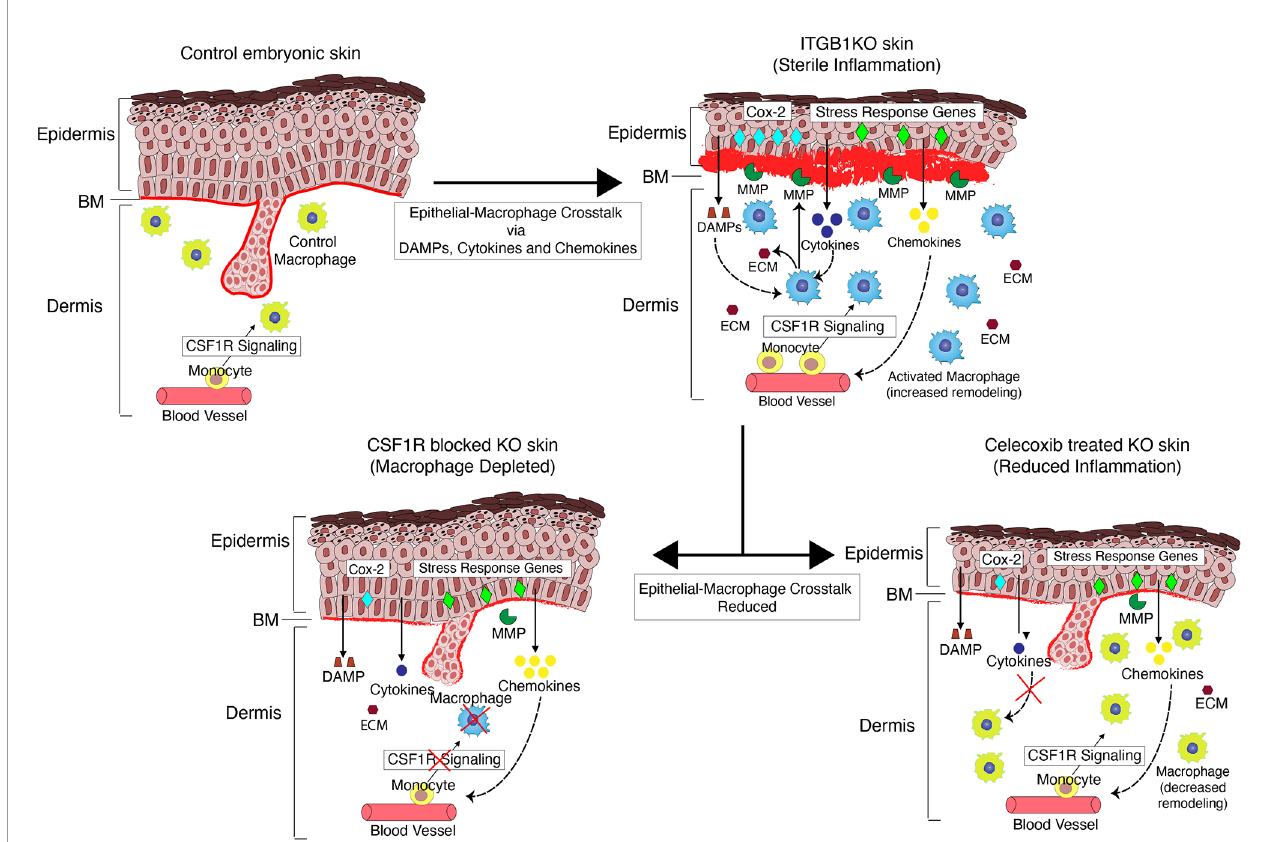
FIGURE 6 | A qualitative model illustrating the epithelial-macrophage crosstalk in the Itg b 1 KO